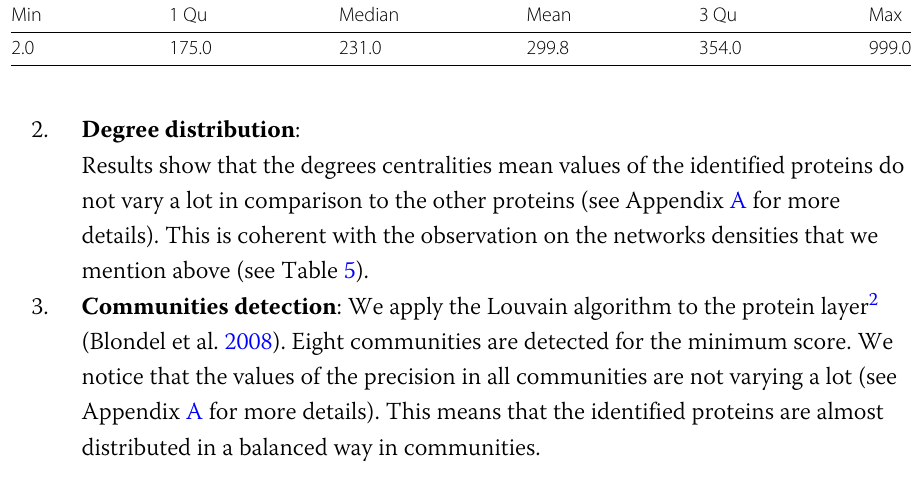
Table 6 The distribution of the combined score according to the STITCH data base Min 1 Qu Median Mean 3 Qu Max 2.0 175.0 231.0 299.8 354.0